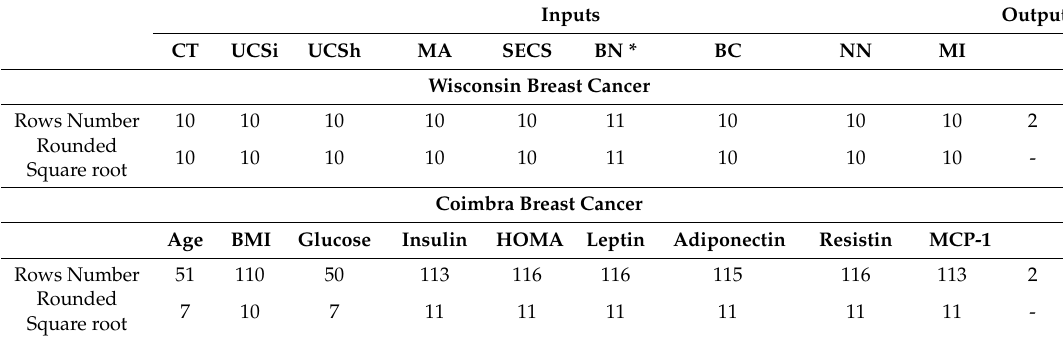
Table 7. Optimal clusters number for breast cancer